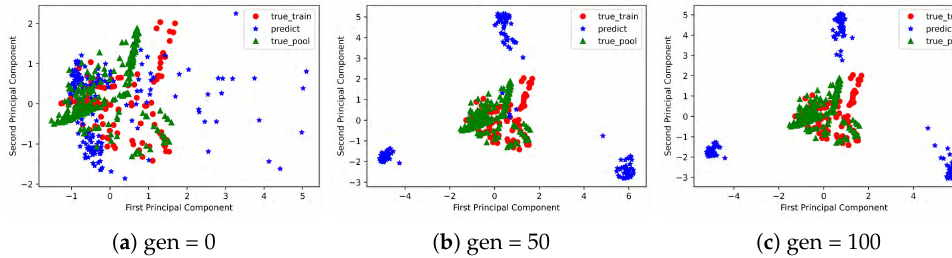
Figure 12. Population evolution of MPUSMs-IMFEOA based on the RBM surrogate